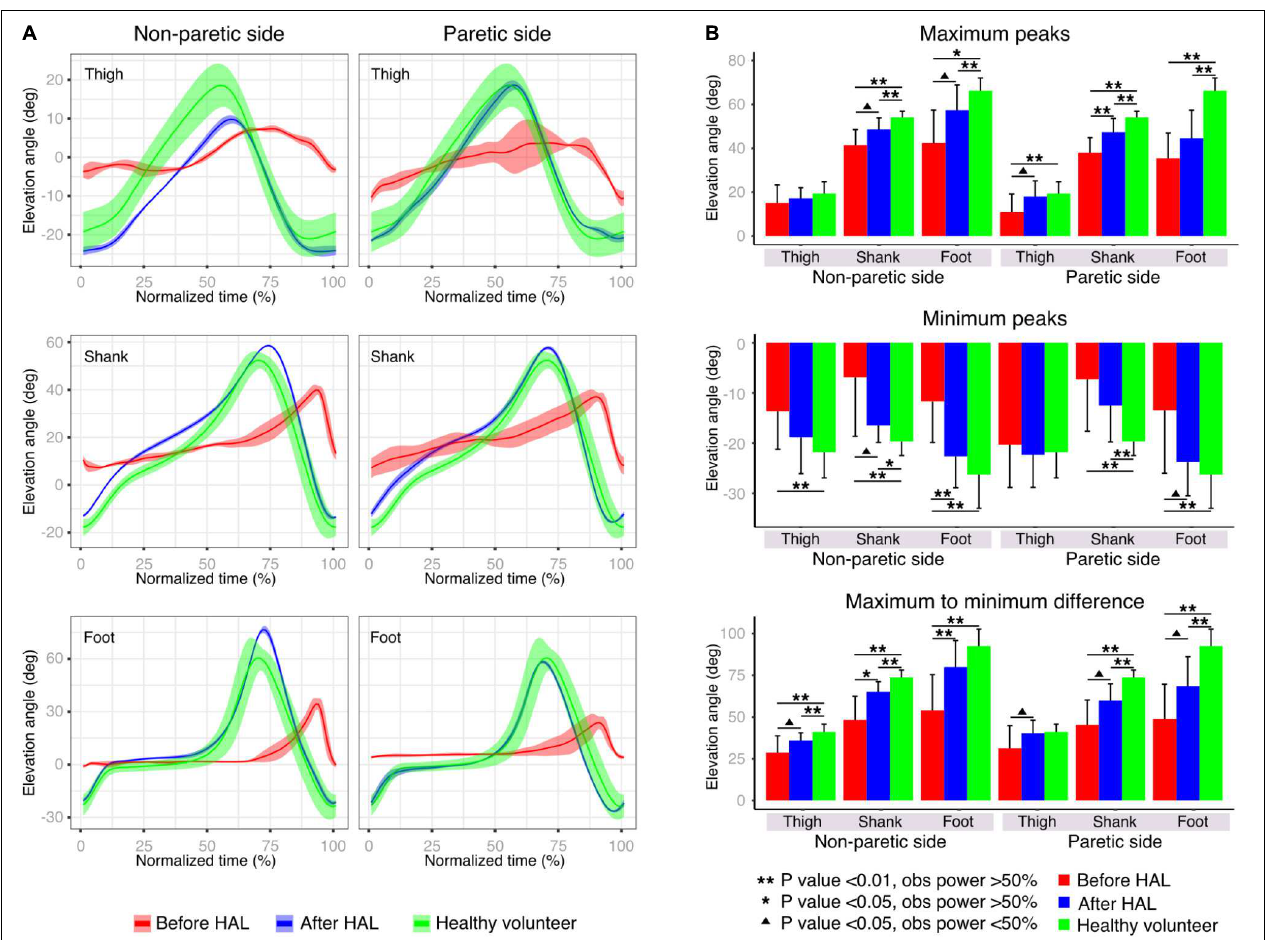
FIGURE 3 | Peak analysis. (A) Elevation angle profiles were plotted before and after HAL therapy for each limb segment of one example patient’s paretic and non-paretic leg. The solid line represents the profile mean and width of highlighted area represents the standard deviation. Healthy volunteer plot (green line) is given by the averaged results of all healthy volunteer participants. (B) Maximum peaks, minimum peaks, and maximum to minimum peaks differences were compared for paretic and non-paretic side before and after HAL. As control, results from healthy volunteers were also